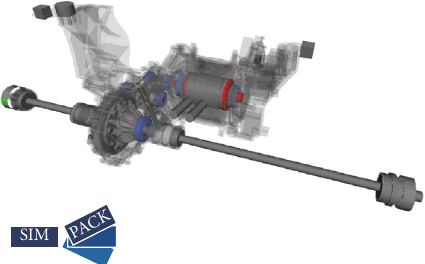
Figure 1: The validated MBS model of an electrified vehicle’s drivetrain.